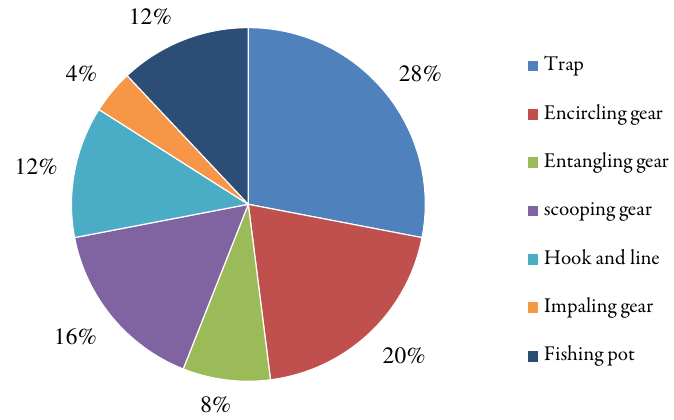
Figure 2. Distribution of various traditional fishing gears in Bankura district Table 1. Types of fishing gears used by fish-farmers of Bankura district, West Bengal,